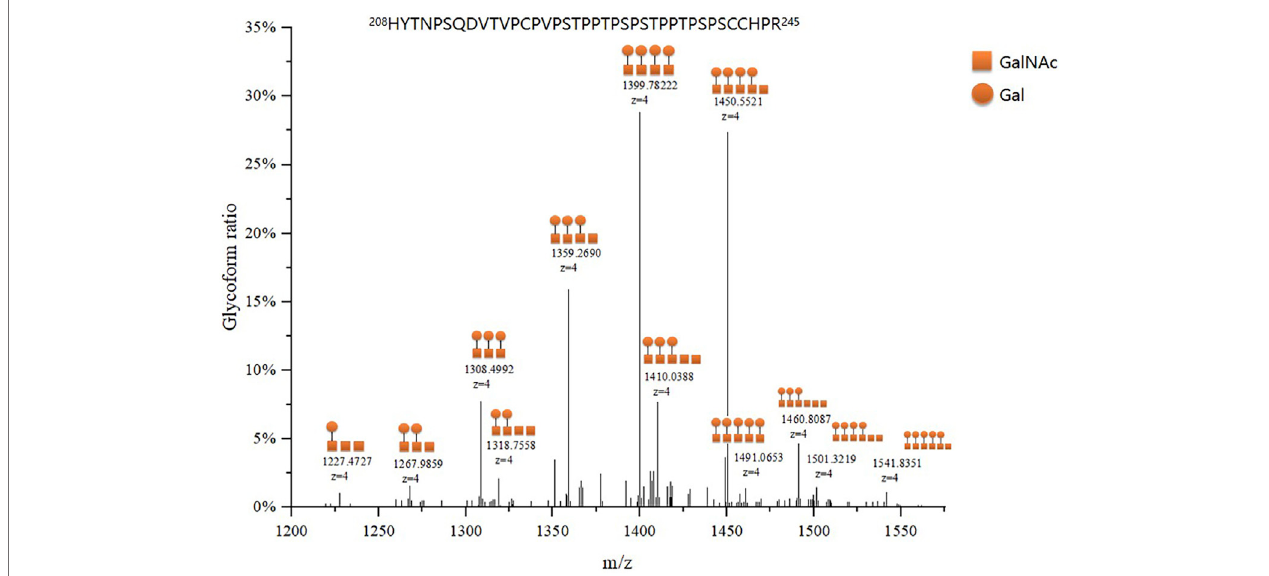
FIGURE3| Representative massspectrumofplasmaIgA1 HRO-glycopeptides. ThemaintwelveIgA1 HRO-glycopeptidesweredetected byLC-EThcD-MS/MS according to the difference in molecular weight arising from different numbers of attached monosaccharides to the peptides of IgA1 HR. Each IgA1 HR glycoform ratio was expressed as a percentage of all O-glycoforms detected.